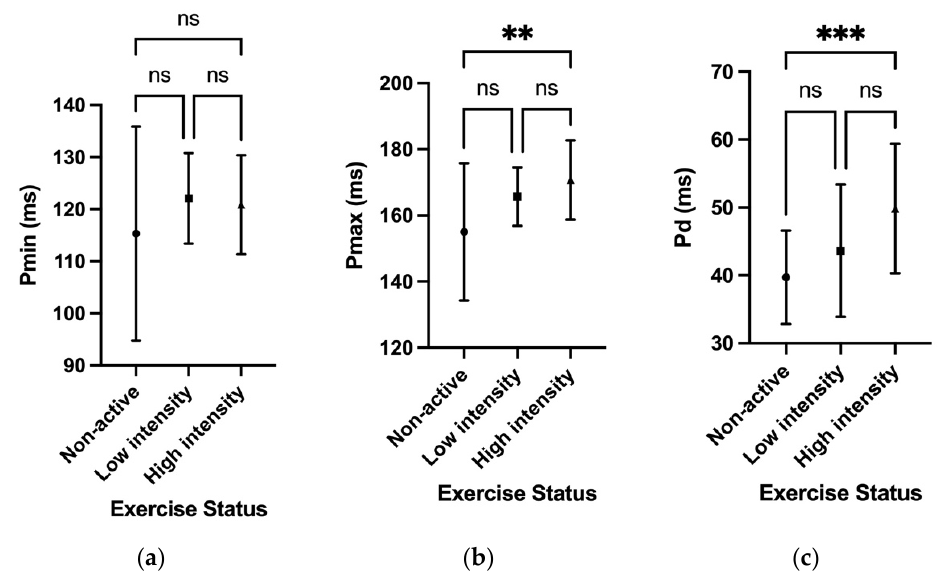
Figure 1. Mean ± SD values for: ( a ) Pmin, ( b ) Pmax and ( c ) Pd for horses according to exercise status